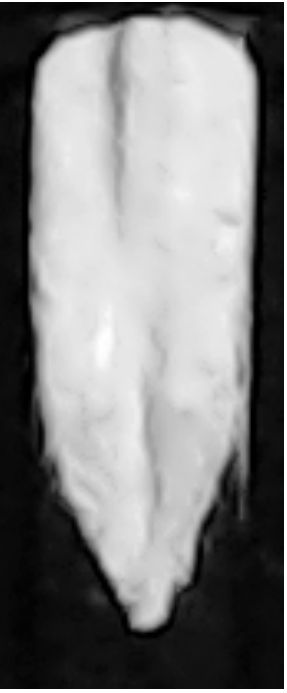
Figure 8. A template T selector-arrow used in the PGM method to detect θ s